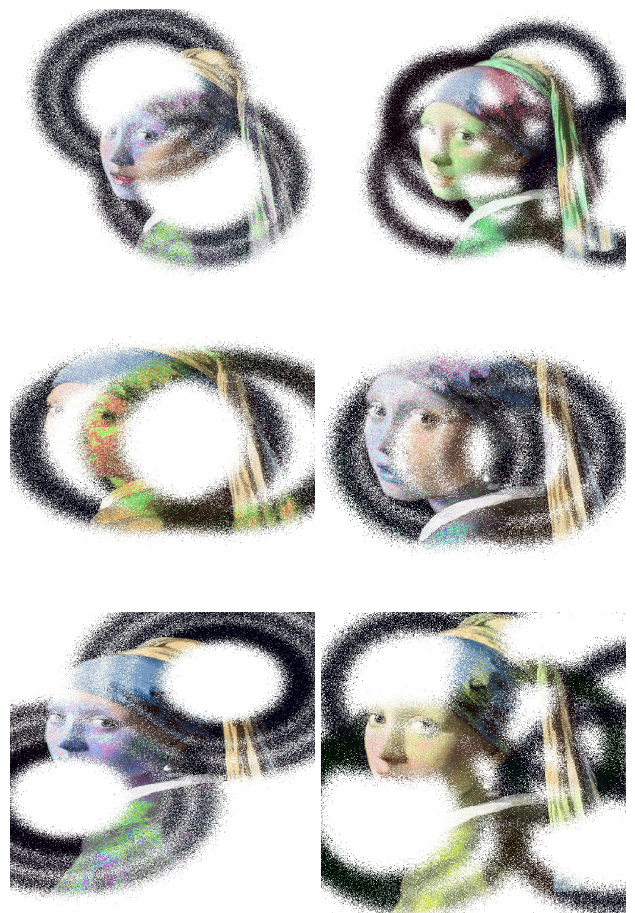
Figure 7. Color symmetric art works, which can be seen as a quotation and homage to Vermeer’s Girl with a Pearl Earring